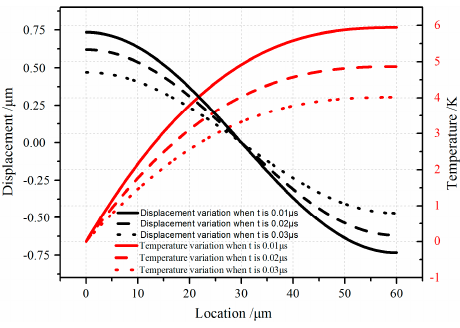
Figure 3. Displacement and temperature variation for different values of vibration width t is 0.01 µs, 0.02 µs and 0.03 µs.